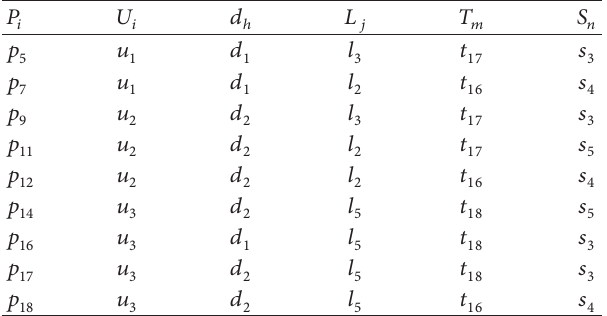
Table 5: Patterns with high interesting